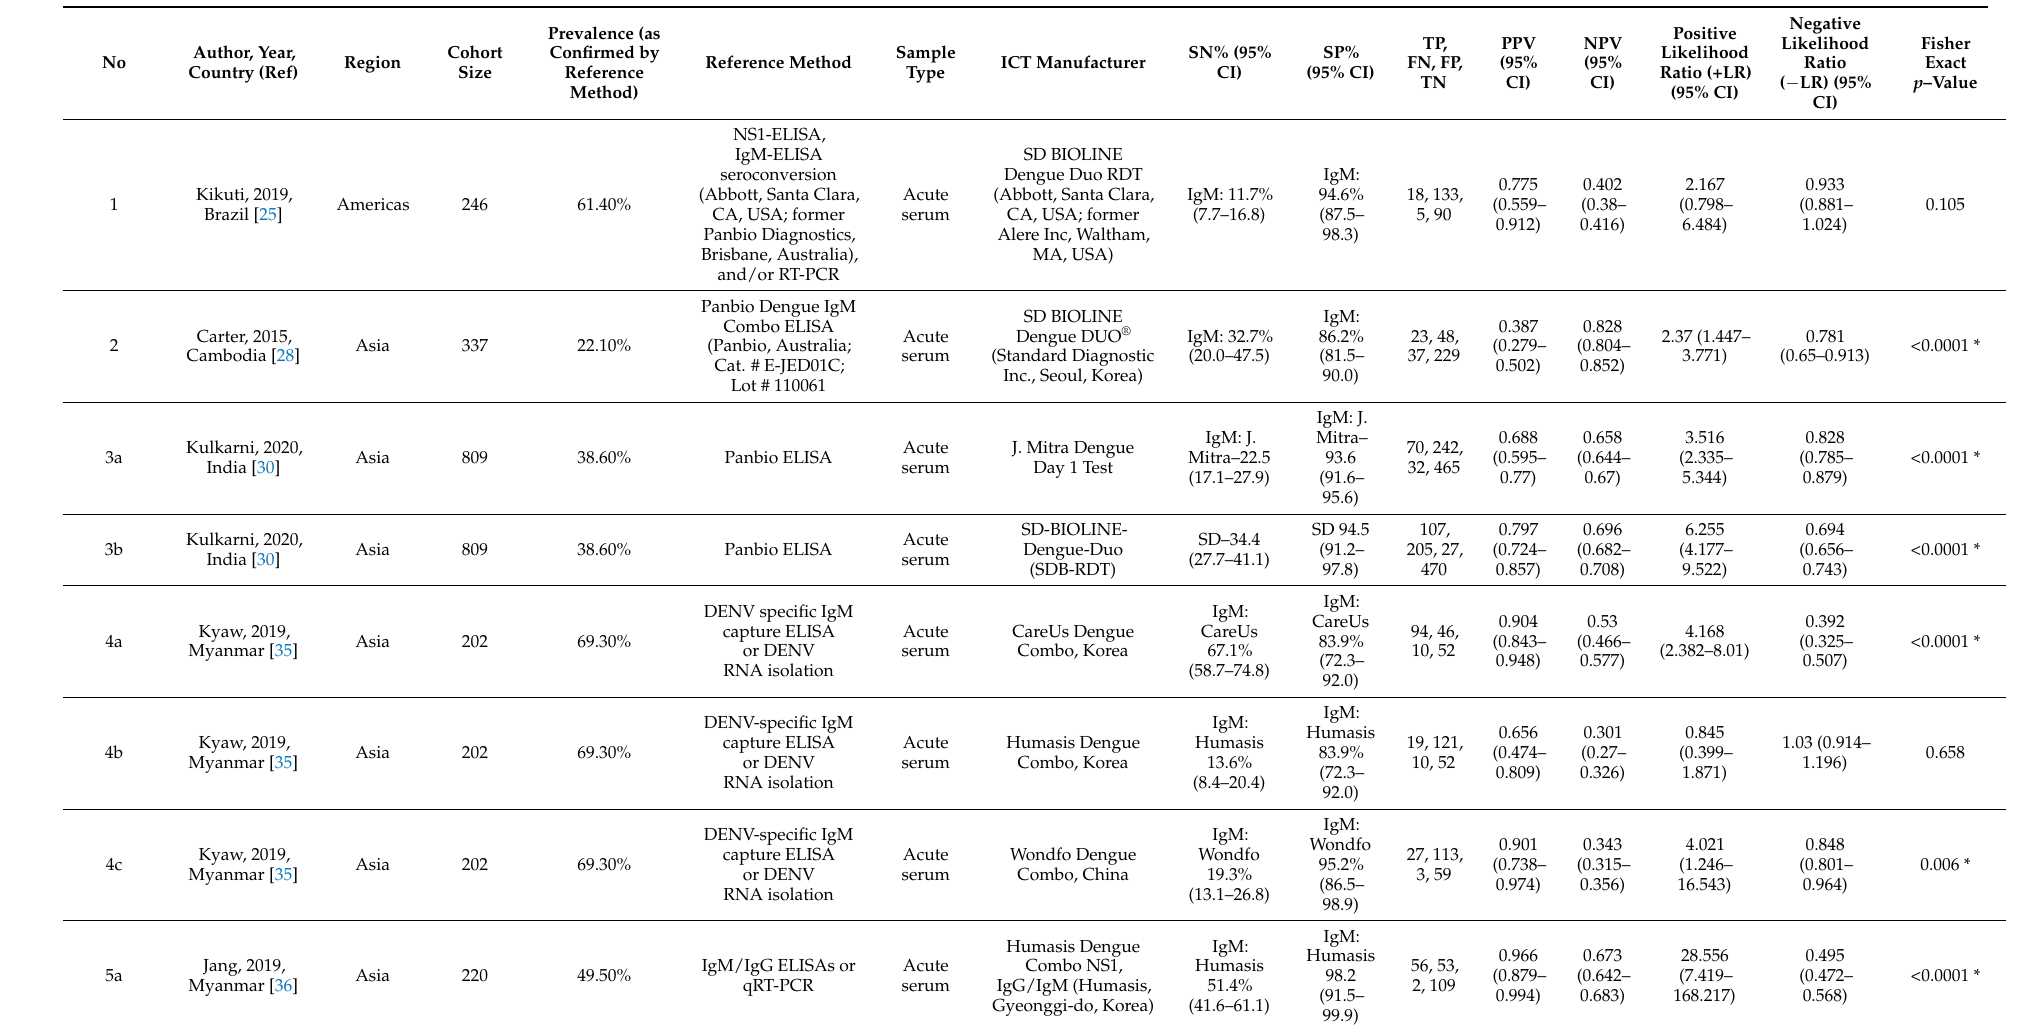
Table 4. IgM (Only) Summary Findings of Post–Hoc